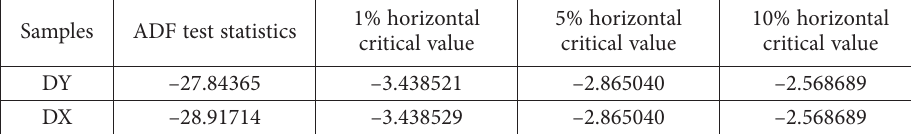
Table 2. First-order differential sequence Dy and Dx unit root test results